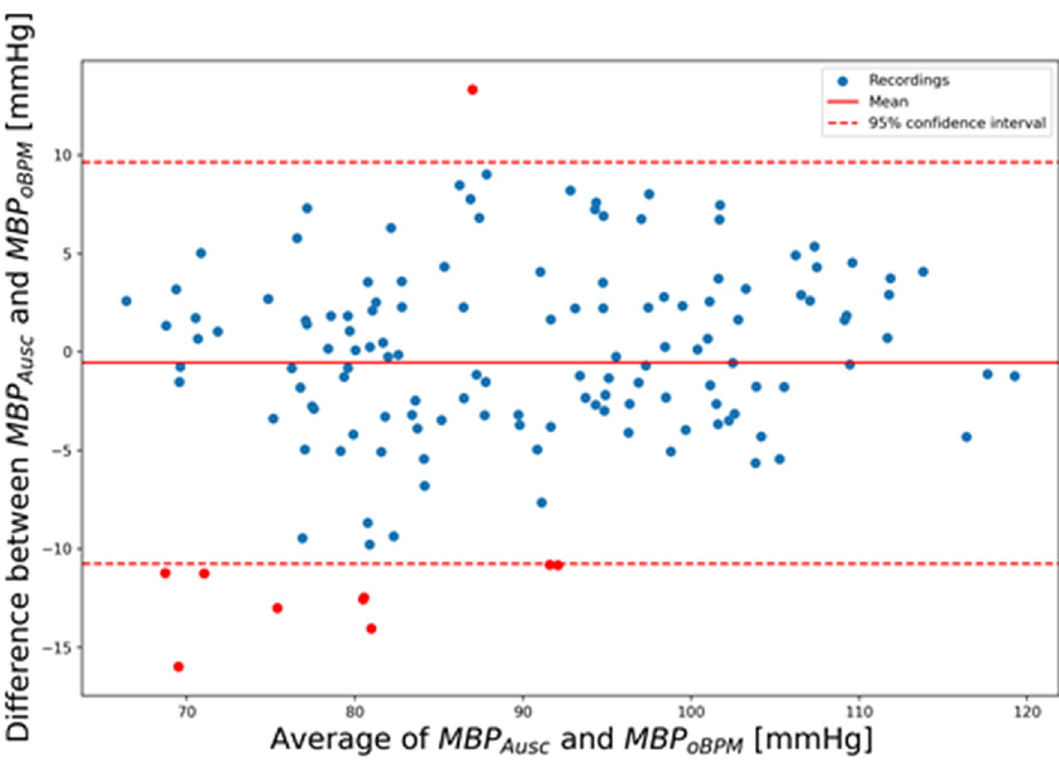
Figure 6. Standardized Bland–Altman scatterplots depicting the agreement between the OptiBP smartphone app mean BP estimates assessed by the oBPM algorithm (MBP oBPM ) and the auscultatory-derived reference systolic BP measurements (MBP Ausc